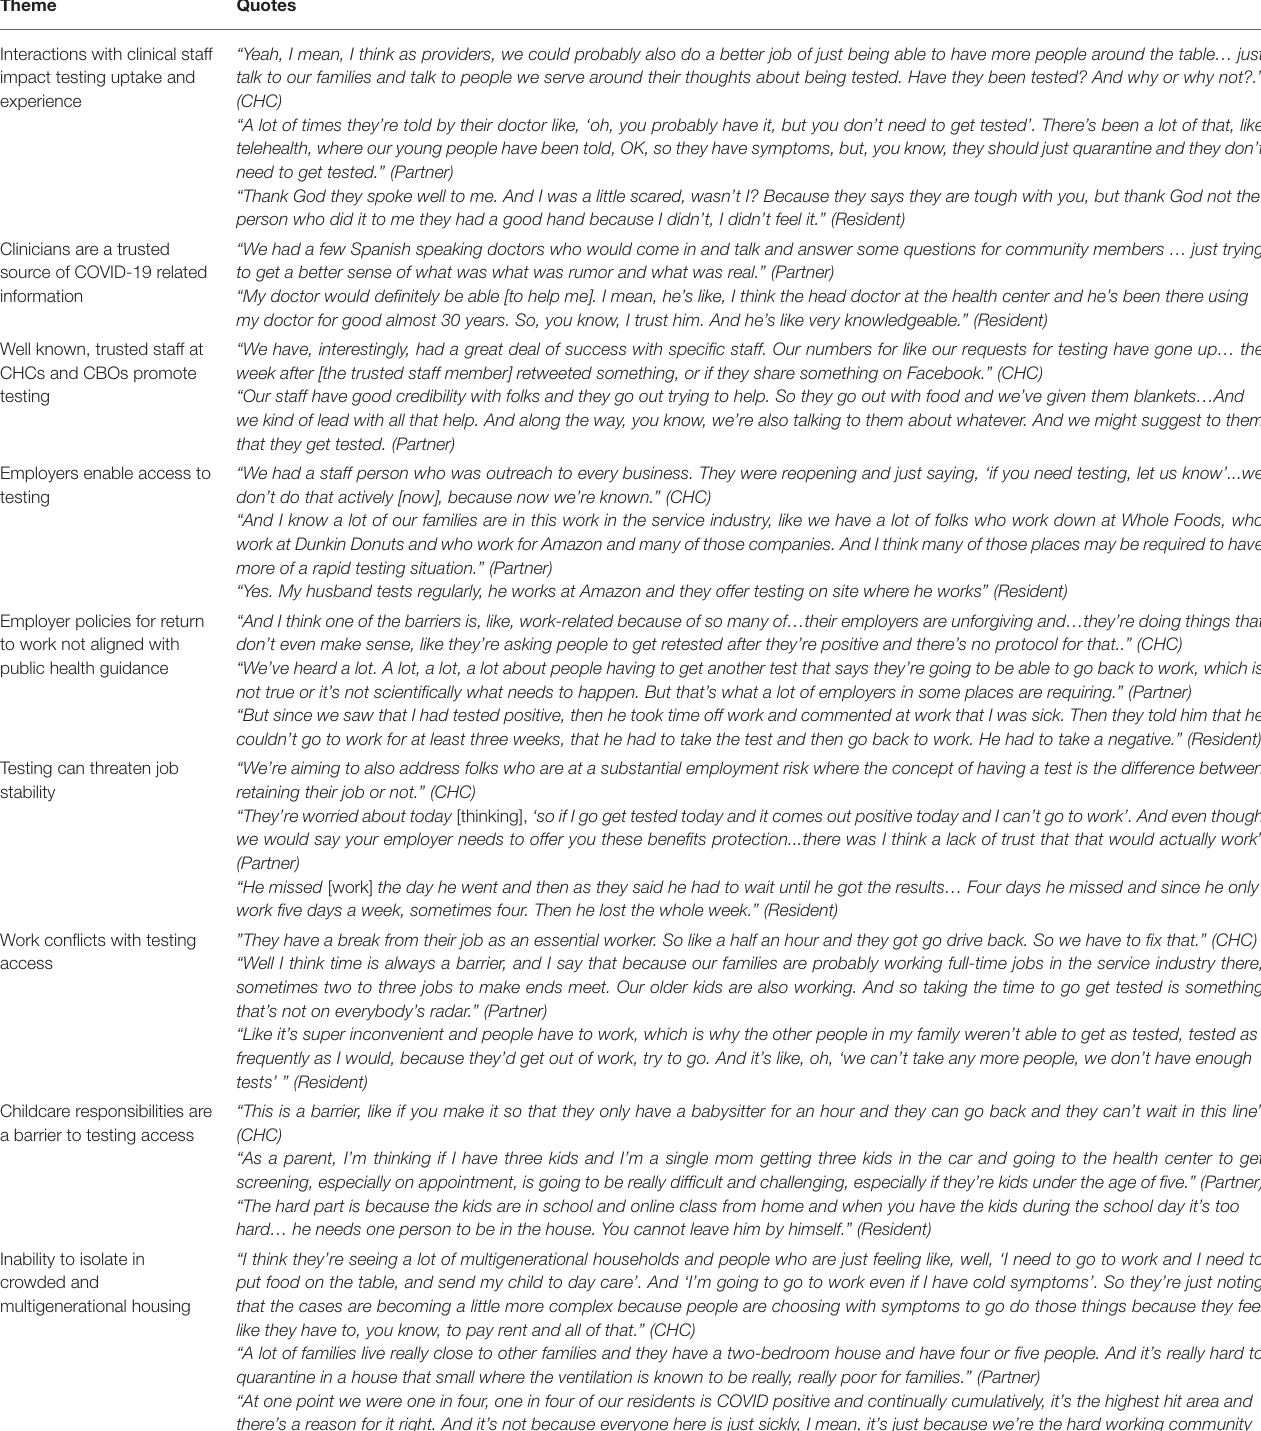
TABLE 4 | Interpersonal factors influencing COVID-19 testing reported by community health center staff, partners, and residents. Theme Quotes Interactions with clinical staff impact testing uptake